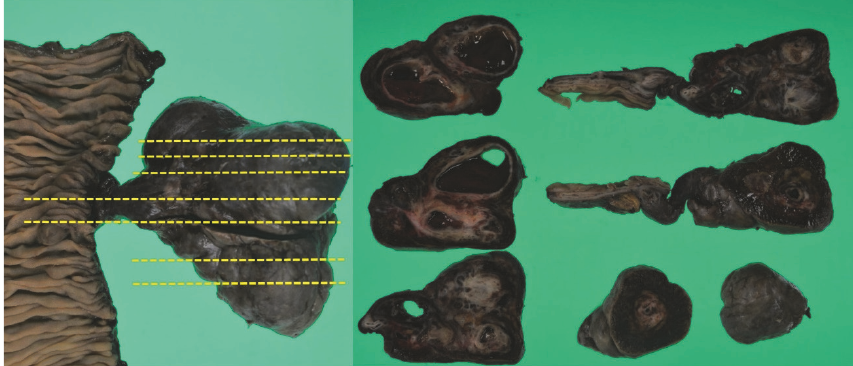
Figure 4: Macroscopically, irregular polycystic appearance was found on the cut surface containing fluid.